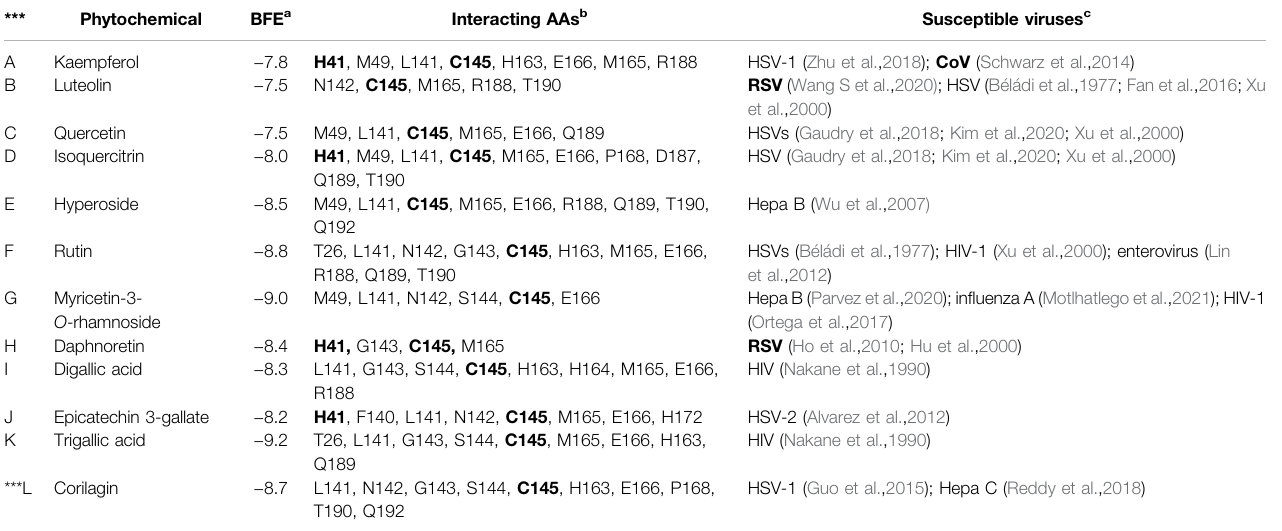
TABLE 2 | In vitro antiviral phytochemicals rediscovered from the medicinal plants used in this study.